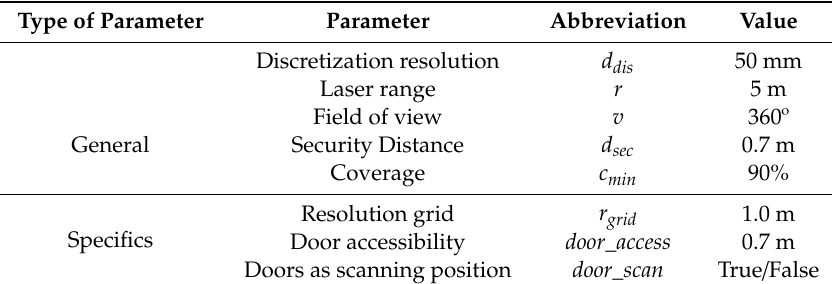
Table 1. Input parameters.